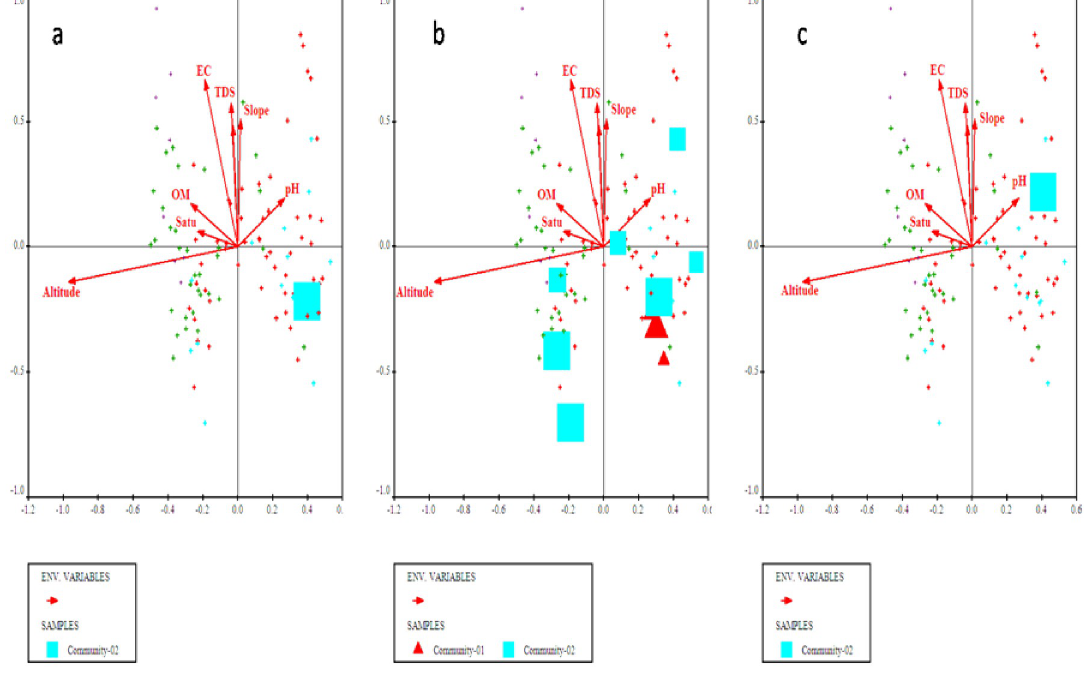
Fig 4. Bi-plot of Abies pindrow , Zanthoxylum alatum and Pteracanthus urticifolius with prevailing environmental variables.